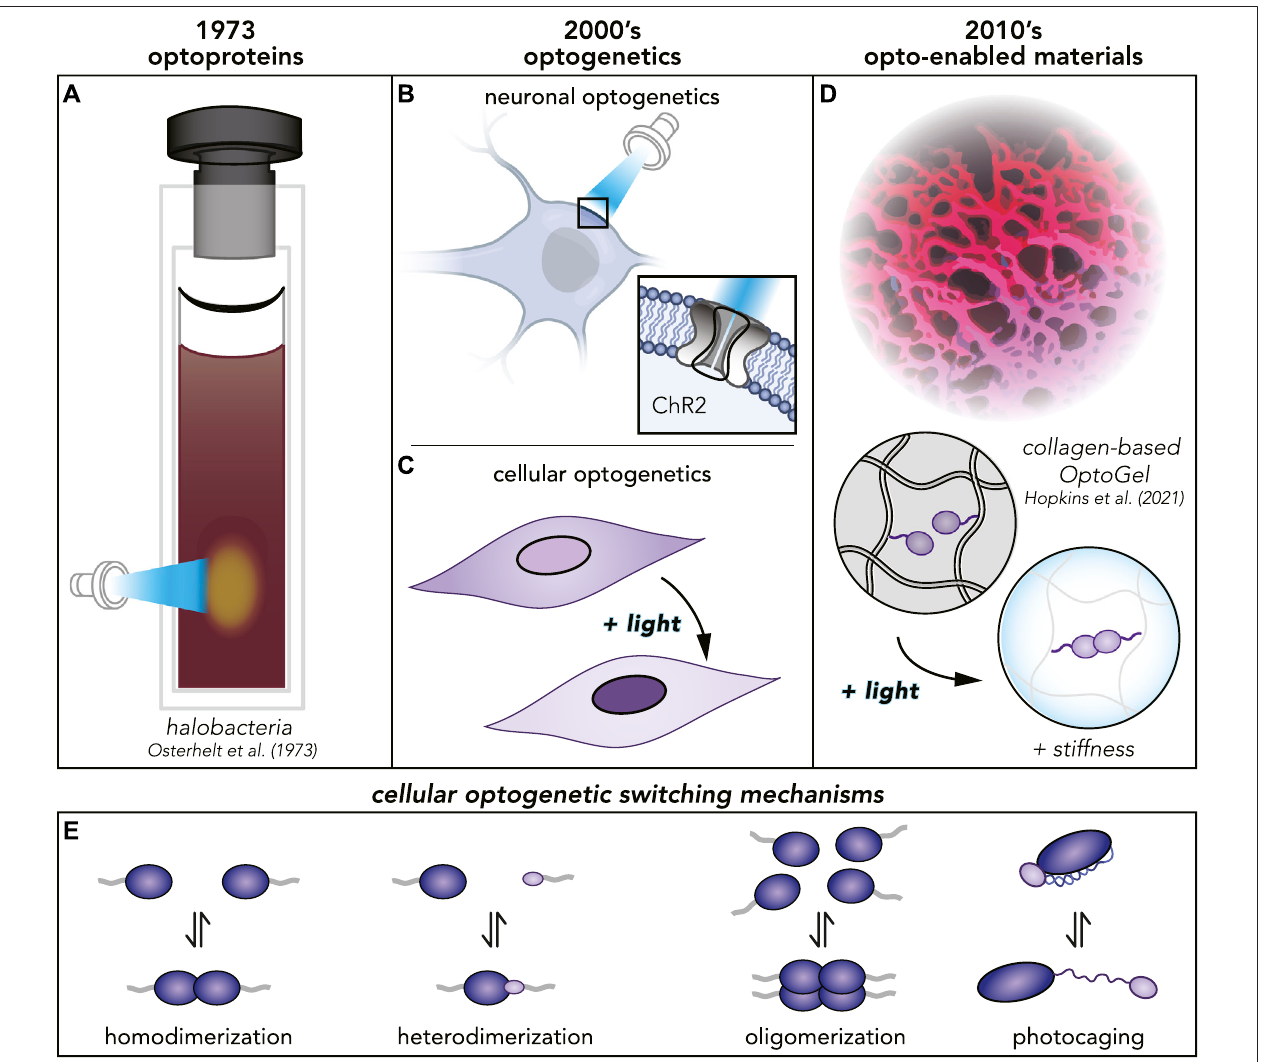
FIGURE1|(A) The fi rstoptoproteinfoundinhalobacteriareported1973. (B,C) Severaldecadeslater,many moreoptoproteinshadbeendiscovered andthe fi eld of optogenetics was born. Optoproteinsare used in neuronalas well as cellular optogenetics with different applications. (D) Today, optoproteins have been puri fi ed and proven to function even in materials. (E) Different photoswitching mechanisms for different optoproteins used in cellular optogenetics.